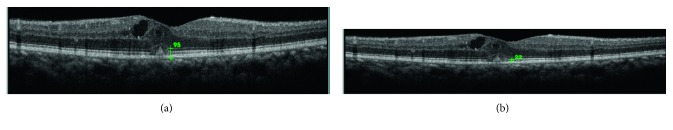
Diabetic patient with BCVA 20/50 (0.4 logMAR). Central subfield thickness is 354 µm, ORL thickness is 95 µm, and PROS length is 22 µm.